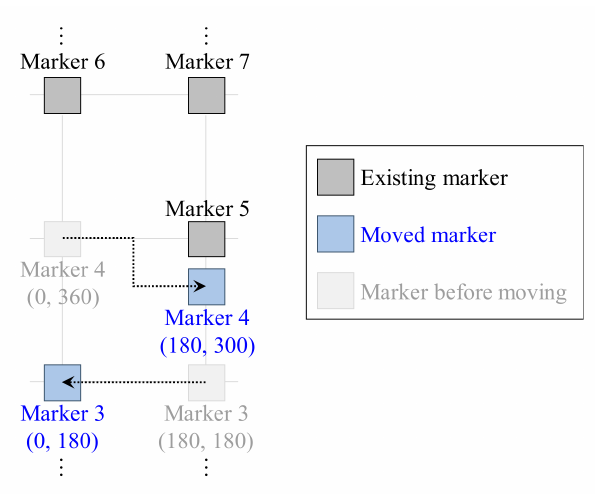
Figure 15. Test condition to verify method of calculating position of moved marker. After changing their positions, the global positions of the markers were estimated. Table 5 shows the actual and estimated position of markers 3 and 4 before and after being moved. The global positions of the markers were estimated accurately even after they were